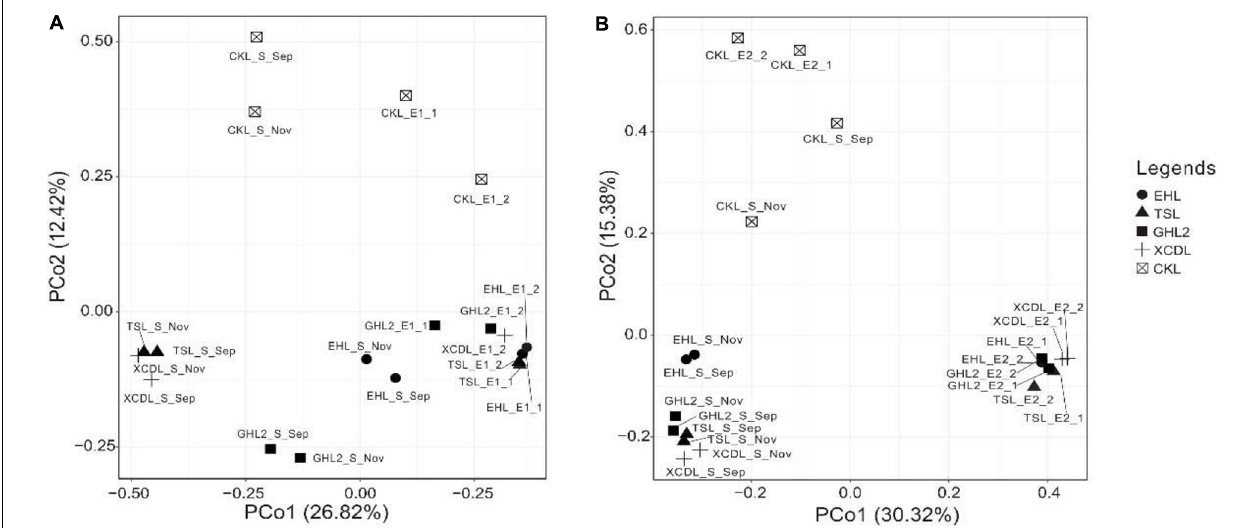
FIGURE 4 | PCoA plots (based on Bray–Curtis dissimilarity matrix) showing relative compositional differences between the lake sediments and transplanted sediments in experiments 1 and 2 ( A,B : simulating salinization and desalinization, respectively). Values on PCoA axes indicate the percentages of total variation explained by each axis.